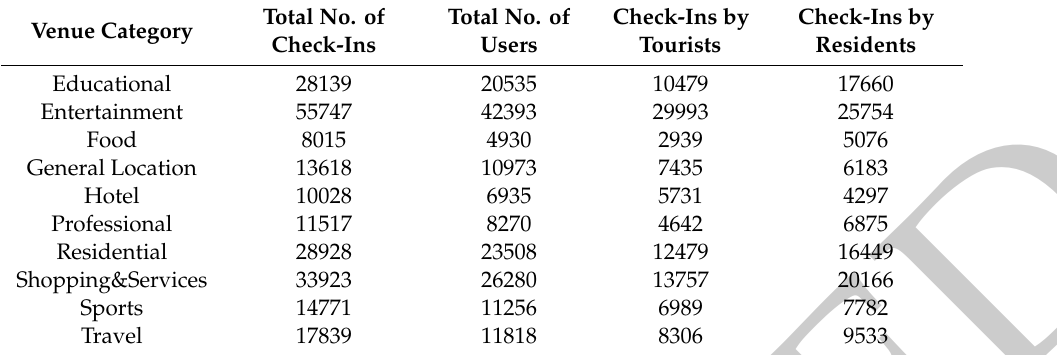
Table 2. Venue types visited by tourists and residents.